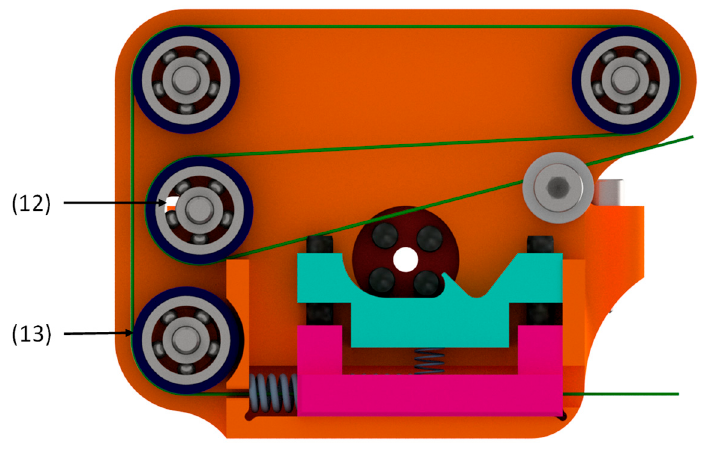
Figure 7. Top view of the actuator to show the guidance of the wire.